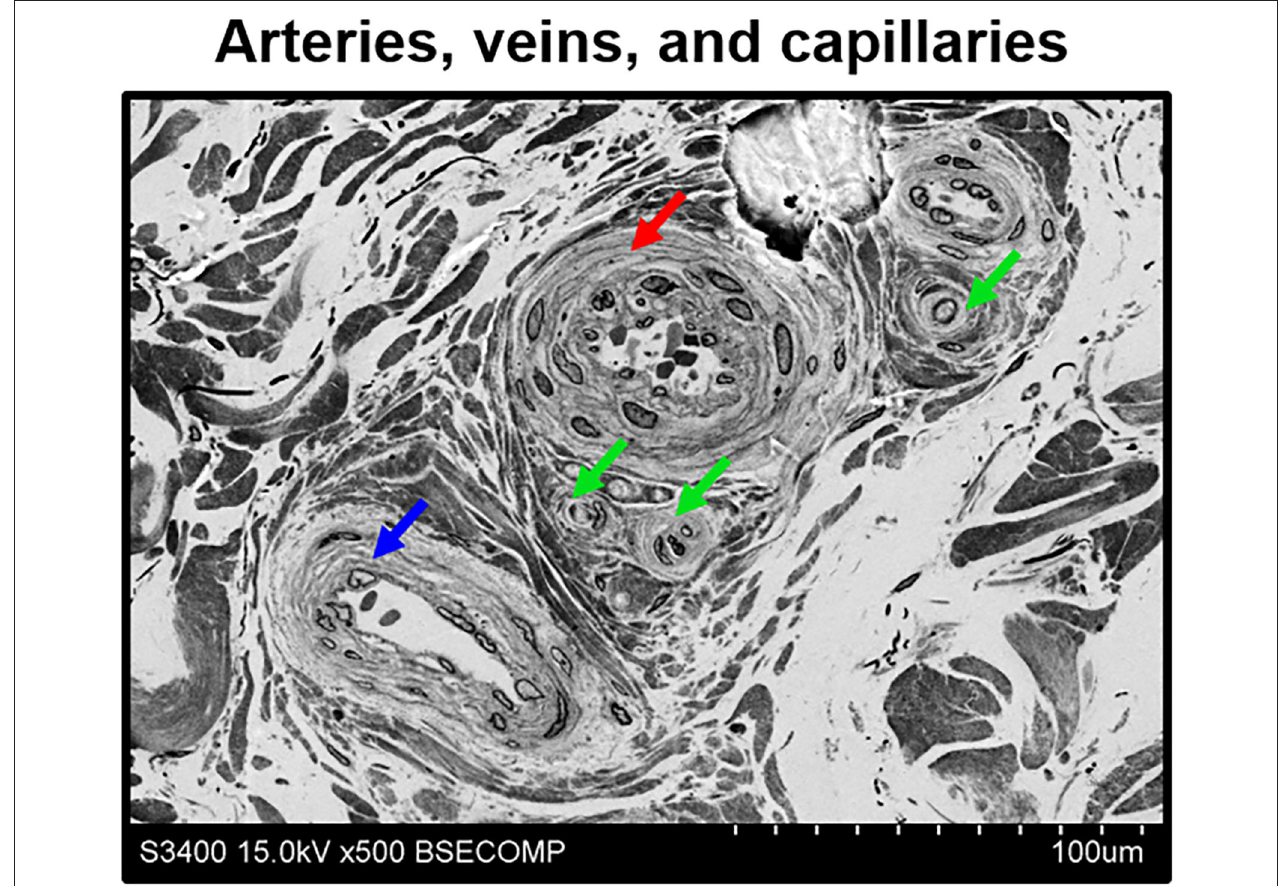
FIGURE 7 | Discrimination of adventitial arterioles, venules, and capillaries by means of EM-BSEM. Human saphenous vein excised for coronary artery bypass graft surgery purposes. Note that despite all microvessels having an endothelial cell monolayer, arterioles (indicated by a red arrow) and venules (indicated by a blue arrow) additionally include ≥ 1 concentric layer of vascular smooth muscle cells, in contrast to capillaries (indicated by green arrows). In general, arterioles have a narrow lumen and often have large smooth muscle cells, while venules are typically distended and their smooth muscle cells are smaller. A magnification of × 500 (scale bar: 100 µ m), 15 kV accelerating